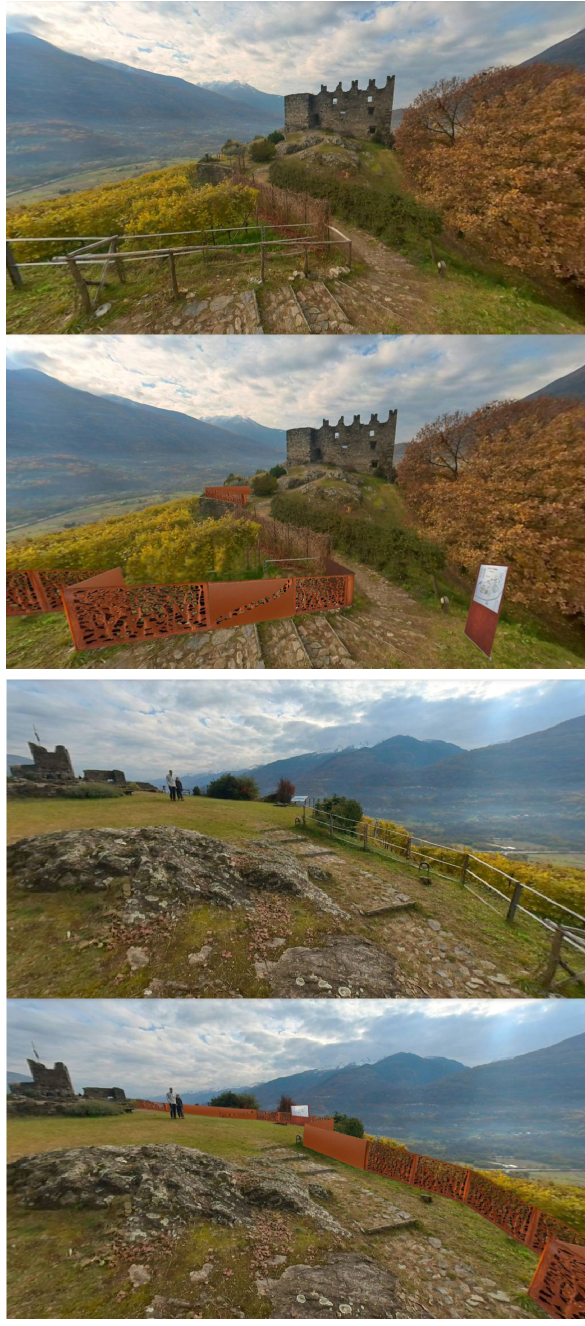
Figure 8: Bubble-views of both original and rendered equirectan- gular